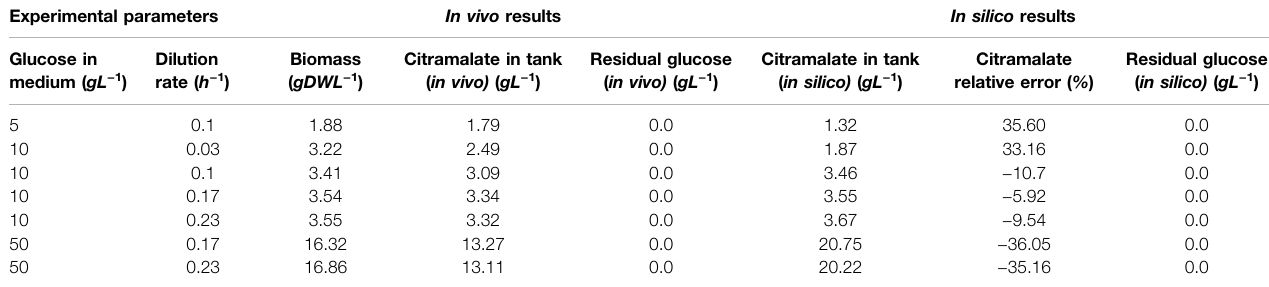
TABLE 2 | Data obtained after running the code that simulates the FN model implementing the experimental conditions and previous results. Experimental parameters In vivo results In silico results Glucose in medium ( gL − 1 )